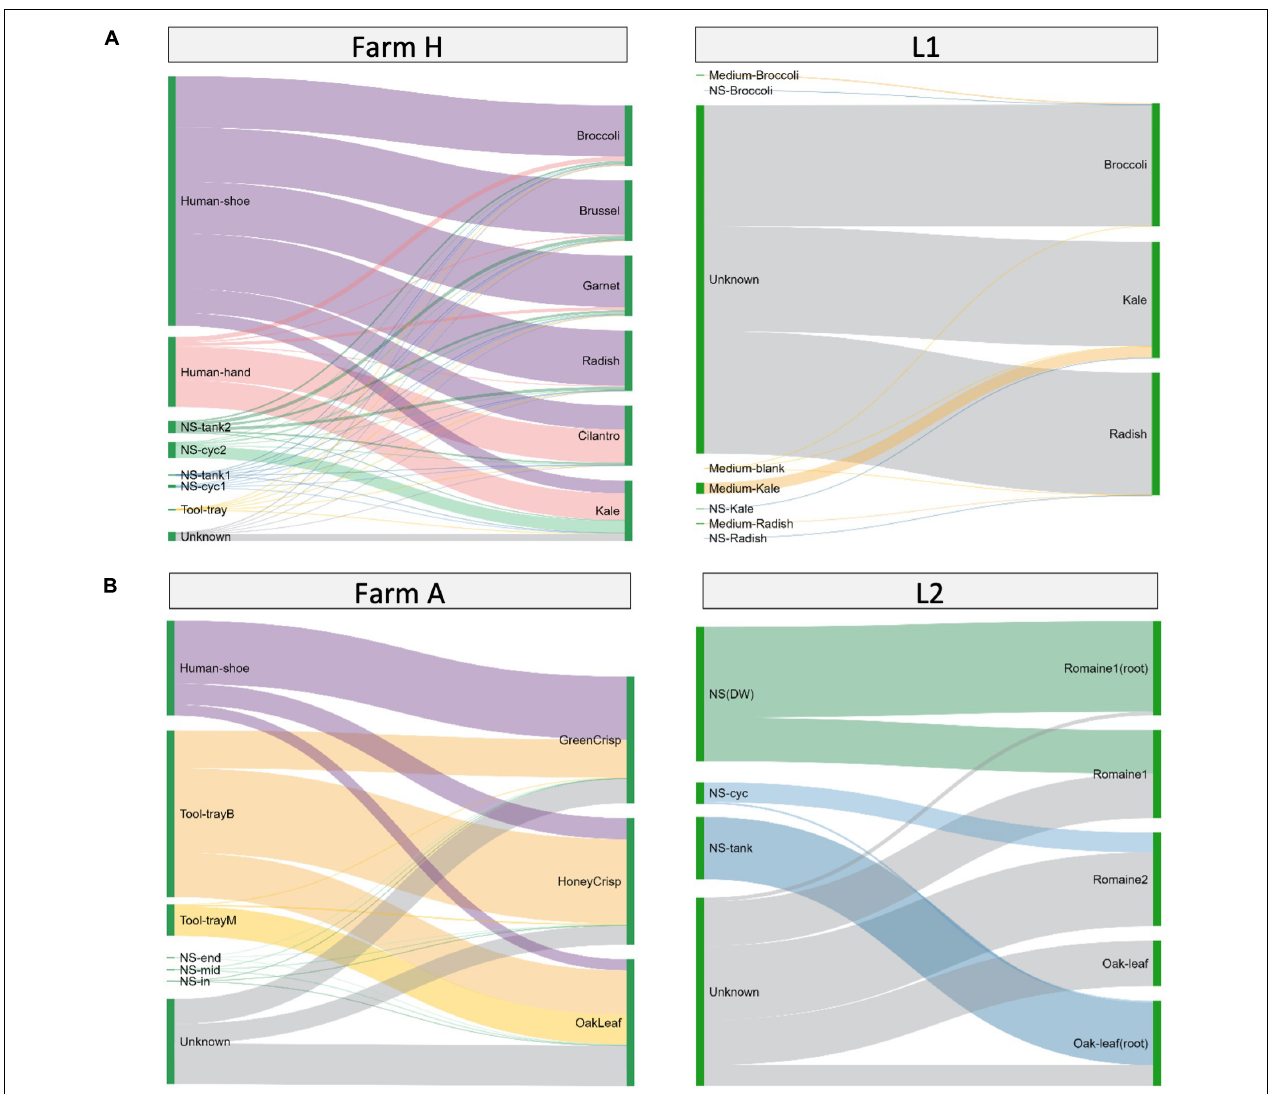
FIGURE 5 | Source environment proportions for hydroponically grown microgreens or lettuces. The samples are grouped by system type of (A) microgreens or (B) lettuce. Source environment proportions for fresh produce samples estimated using SourceTracker and visualized as Sankey flow diagrams. Environmental source samples are presented on the left and fresh produce samples are “sinks” and presented on the right. The line width of individual flows indicates the percentage contribution of microorganisms from the source to the sink. The contribution proportions from different sources sum up to 100% on the sink sample (right side). The height of individual bars (left side) of source samples represents the sum of proportions to each of the sink